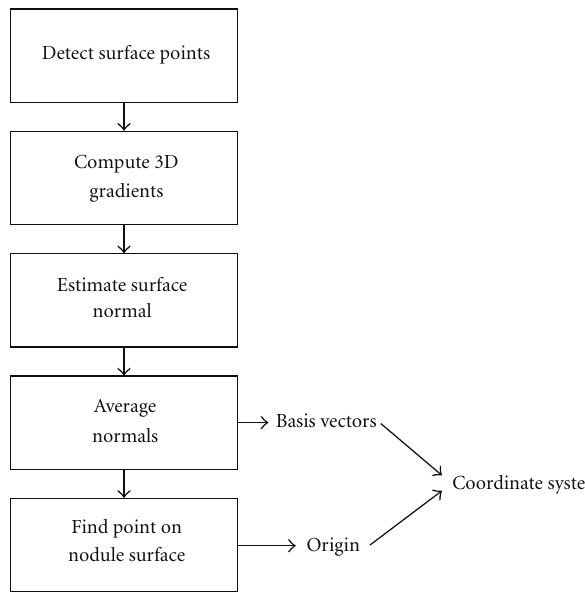
Figure 5: Overview of coordinate system selection.